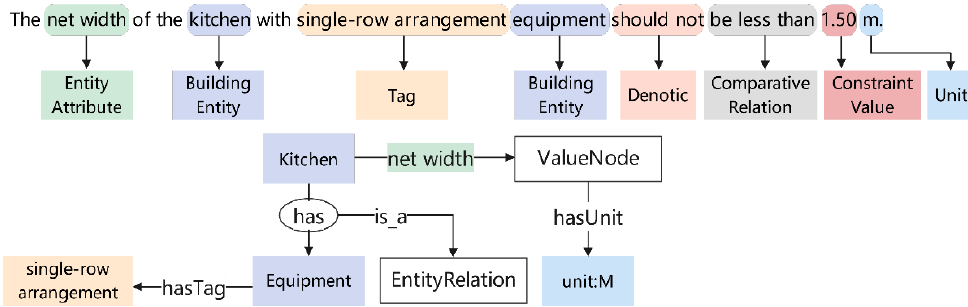
Figure 3. An example of a clause-entity knowledge graph. Here, the proposed top schema is en-